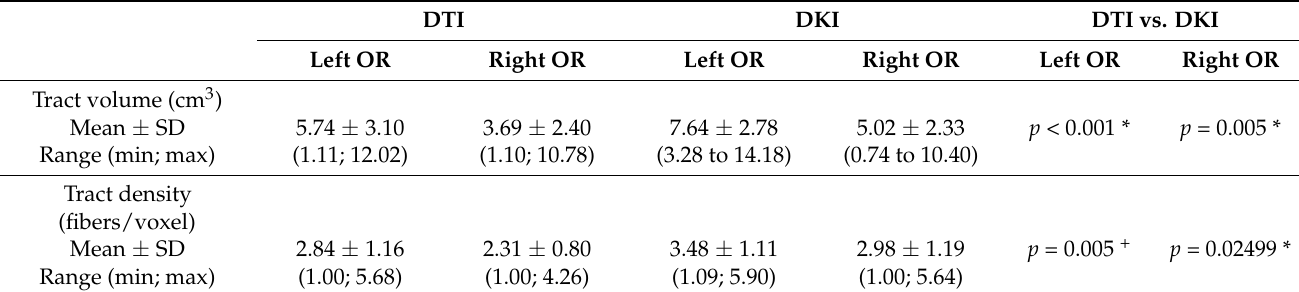
Table 3. Results of fiber tractography of the optic radiation (OR) in healthy volunteers. DTI DKI DTI vs. DKI Left OR Right OR Left OR Right OR Left OR Right